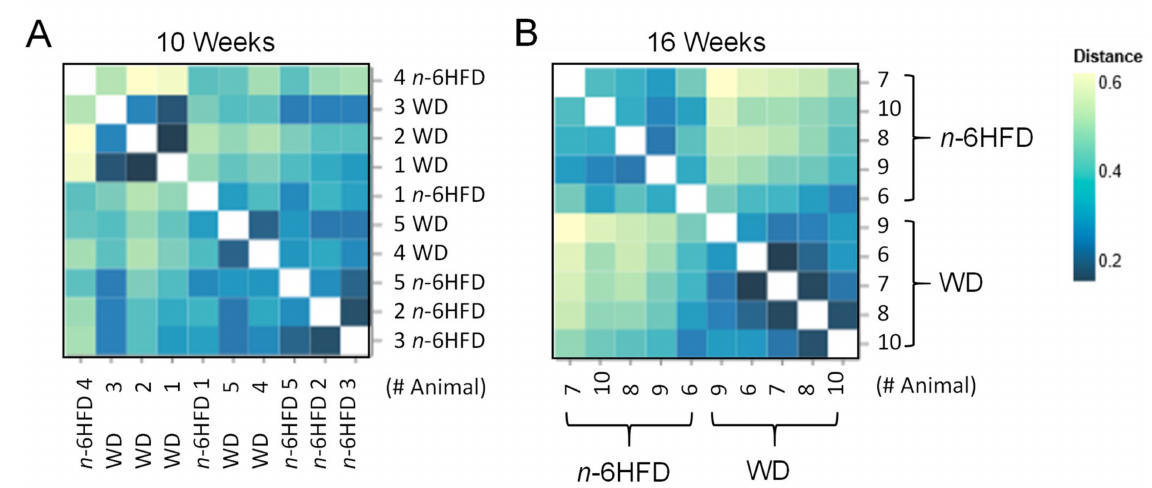
Figure 6. Bray–Curtis Distance Matrix of the cecal microbiota from WD- and n -6HFD-fed C57BL/J6 male mice. Bray–Curtis ordination plots based on the bacterial profiles for each mouse at ( A ) 10 weeks and ( B ) 16 weeks. Distance of microbiota between WD and n -6HFD-fed mice increases with decreasing color intensity ( n =